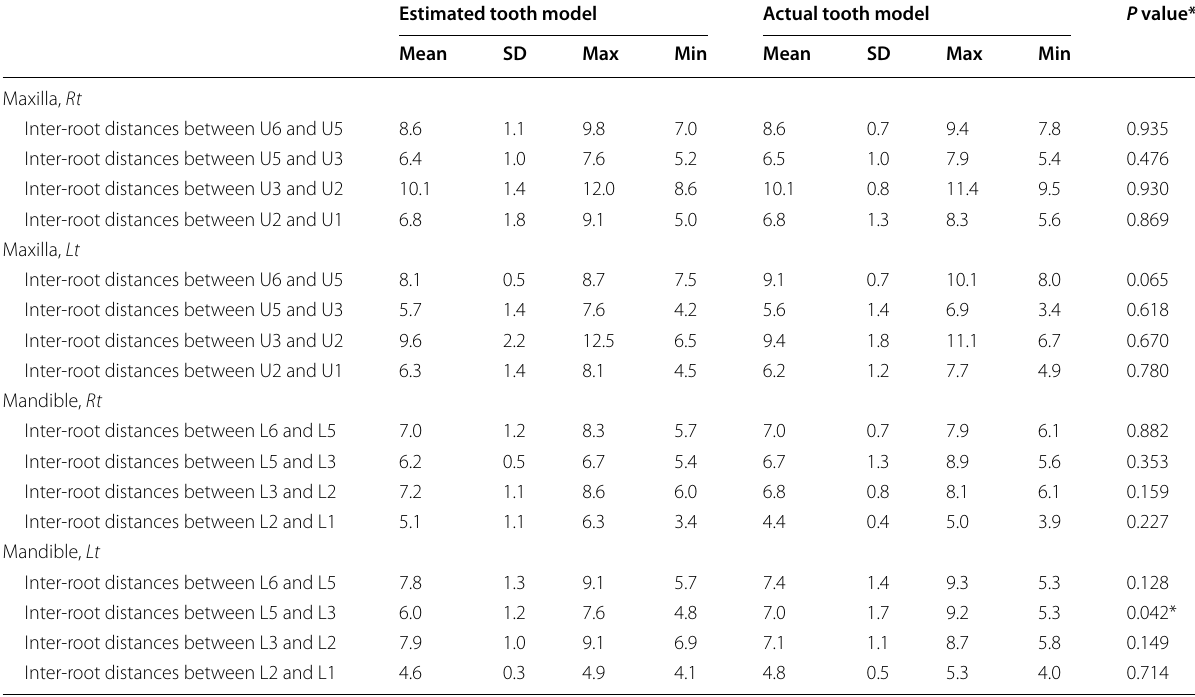
SD, Standard deviation *The results of paired t test. U6, maxillary first molar; U5, maxillary second premolar; U3, maxillary canine; U2, maxillary lateral incisor; U1, maxillary central incisor. L6, mandibular first molar; L5, mandibular second premolar; L3, mandibular canine; L2, mandibular lateral incisor; L1, mandibular central incisor